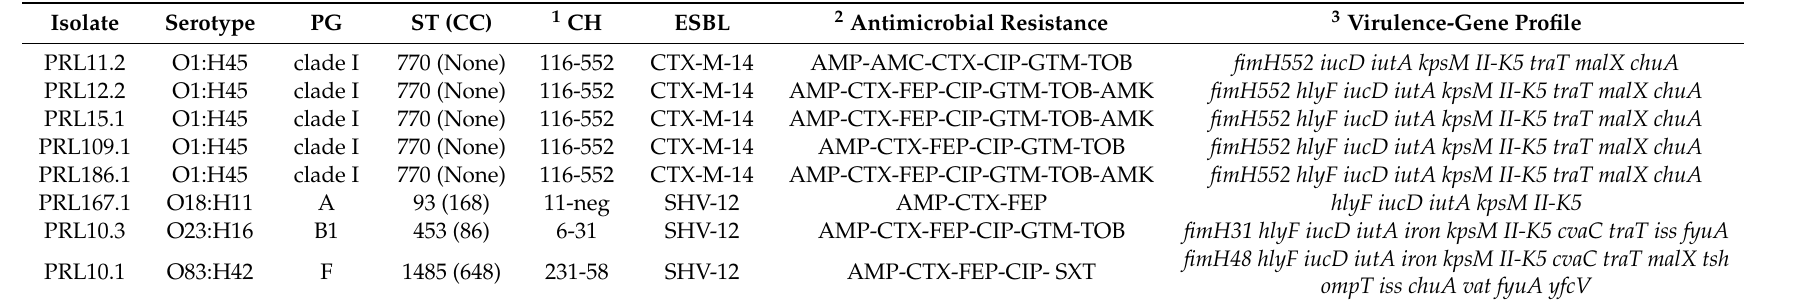
Table 1. Phenotypic and genotypic characterization of the eight E. coli conforming the ExPEC